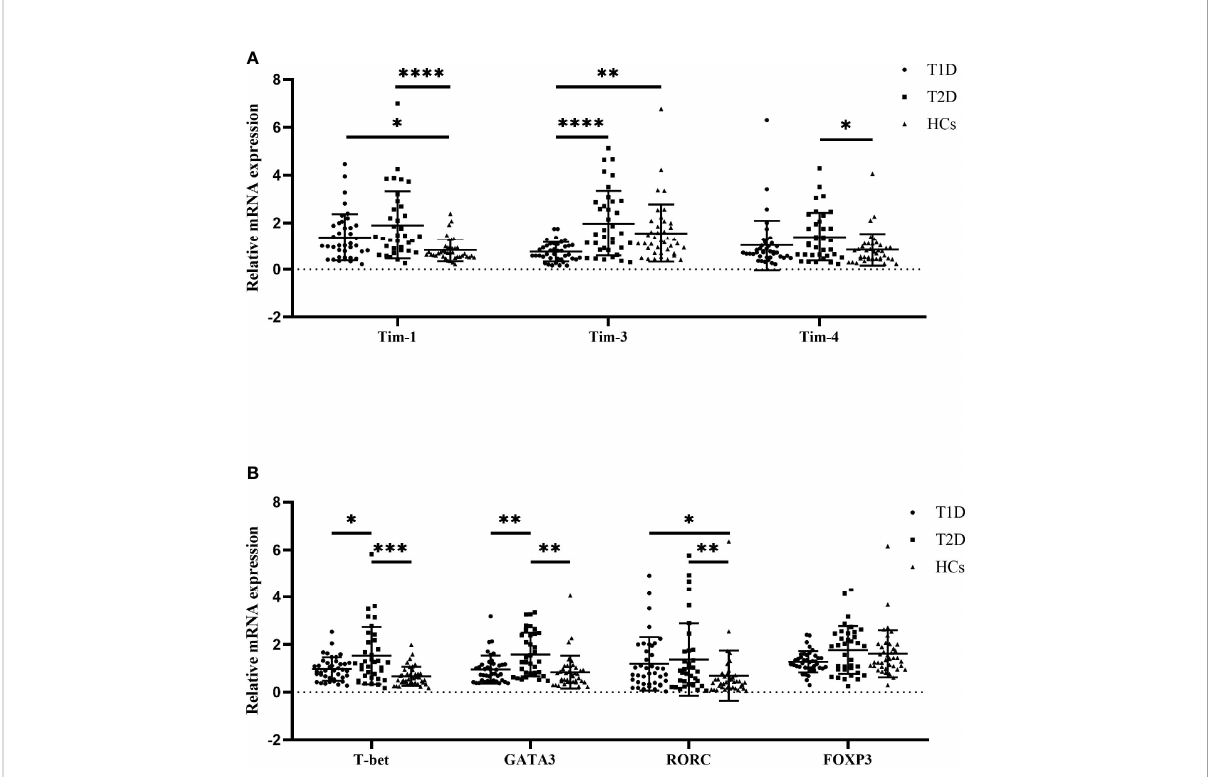
FIGURE 1 The mRNA expression levels among T1D patients (n=40), T2D patients (n=36) and HCs (n=40) as quanti fi ed by RT – qPCR. (A) Tims mRNA expression in PBMCs from T1D patients, T2D patients and HCs. (B) T-cell subset-speci fi c transcription factor mRNA expression in PBMCs from T1D patients, T2D patients and HCs. The error bars represent the standard deviation of the mean. * P <0.05; ** P <0.01; *** P <0.001; **** P